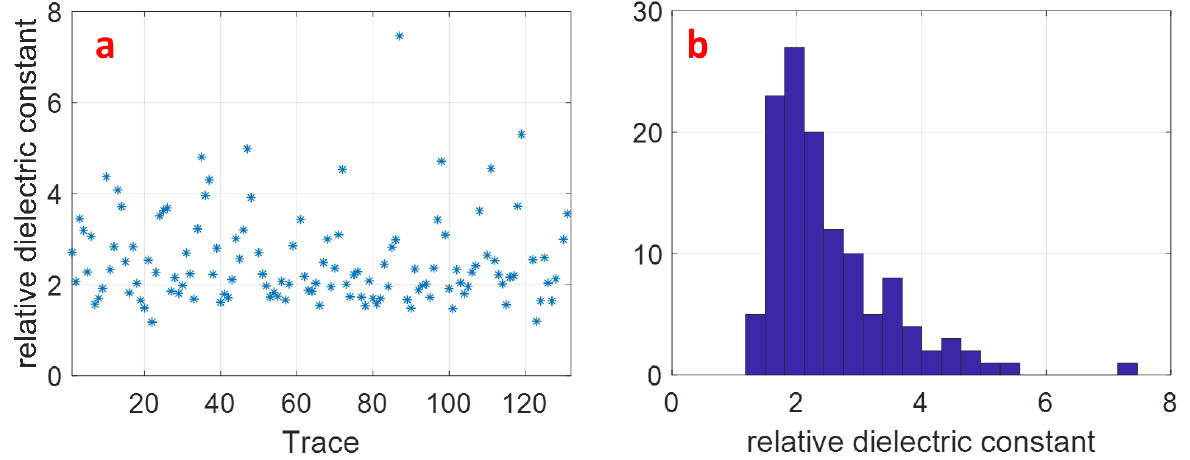
Figure 8. The estimation of the relative constant. ( a ) The relative dielectric constants of 132 channels, which the ‘*’ donate the estimated values. ( b ) The distribution of 132 values. The average value is 2.520, which is employed as the relative dielectric constant of the surface lunar regolith.